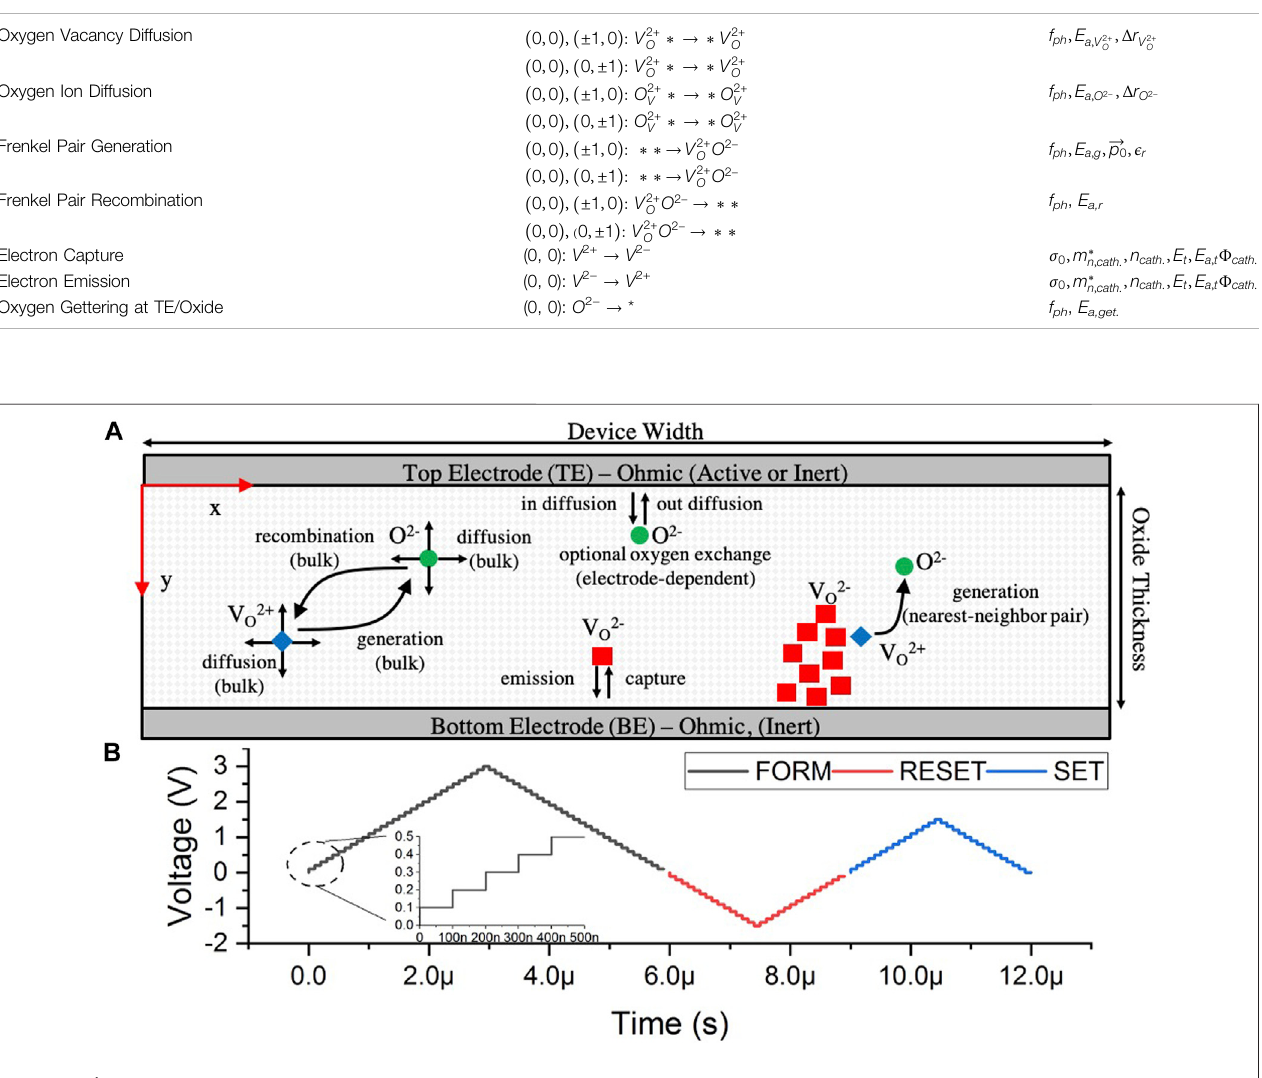
FIGURE 3 | (A) Illustration showing device geometry and description of the processes modeled using Kinetic Monte Carlo. (B) Example voltage waveform used to perform forming , reset ,and set operations insequenceusing astepped voltage rampwithaKMCsimulationtimeof100 ns.Theresultingstate ofthesystemattheend of each voltage increment is used as input to Synopsys TCAD